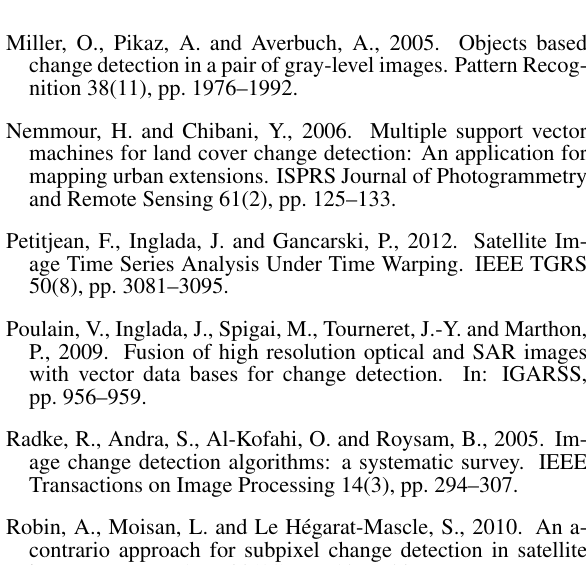
Figure 3: Results of the change detection method: (a) Orthoimage of the area of interest, (b) Probability change map (red: change – blue area: no change – white: confusing areas; (c) Forest theme (d) Field theme; (e) and (f) Classification results after DB fusion for the Forest and the Field themes, respectively; (g) and (h) Differences between the DB and the classification ( ■ : new areas and ■ disappeared areas) for the Forest and the Field themes,